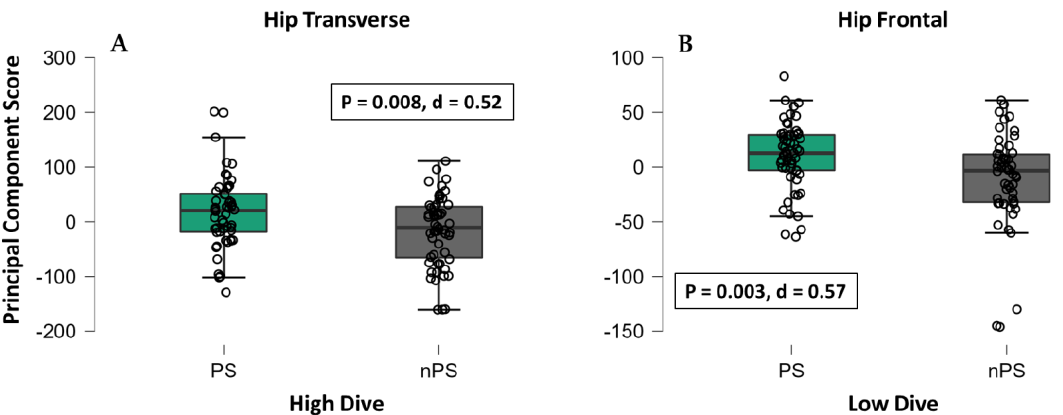
Figure 6. Example Principal Component scores for preferred and non-preferred sides in high dive ( A ) and low dive ( B ). Note: PS = preferred diving side; nPS = non-preferred diving side; the full list of p -values and Cohen’s d is reported in Tables 5 and 6.